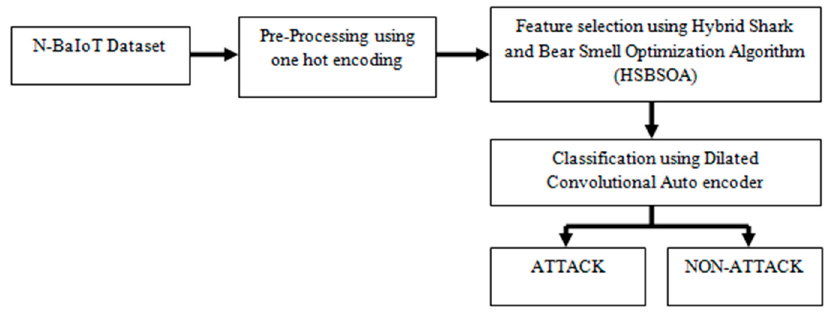
Figure 1. Block schematic illustration for attack classification.